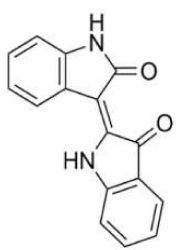
Figure 1. Structure of